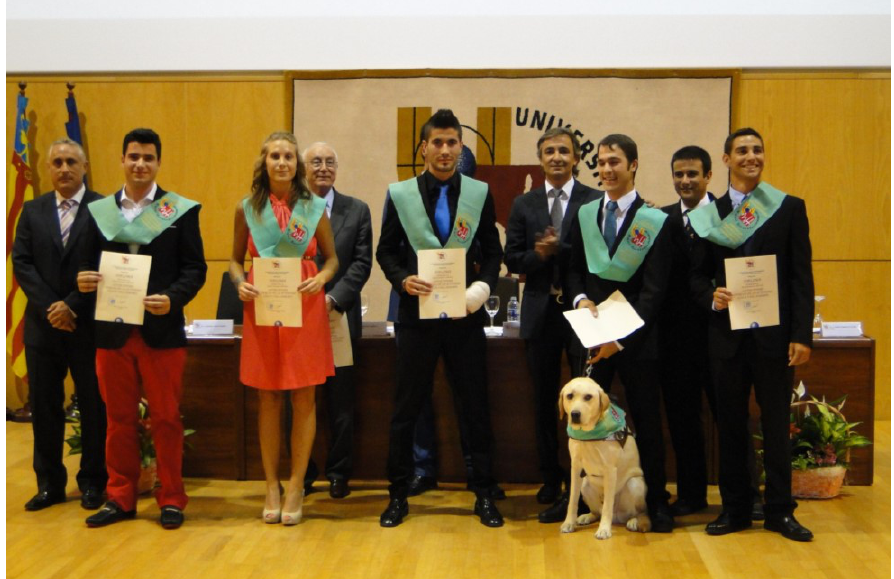
Figure 6. Javier´s graduation